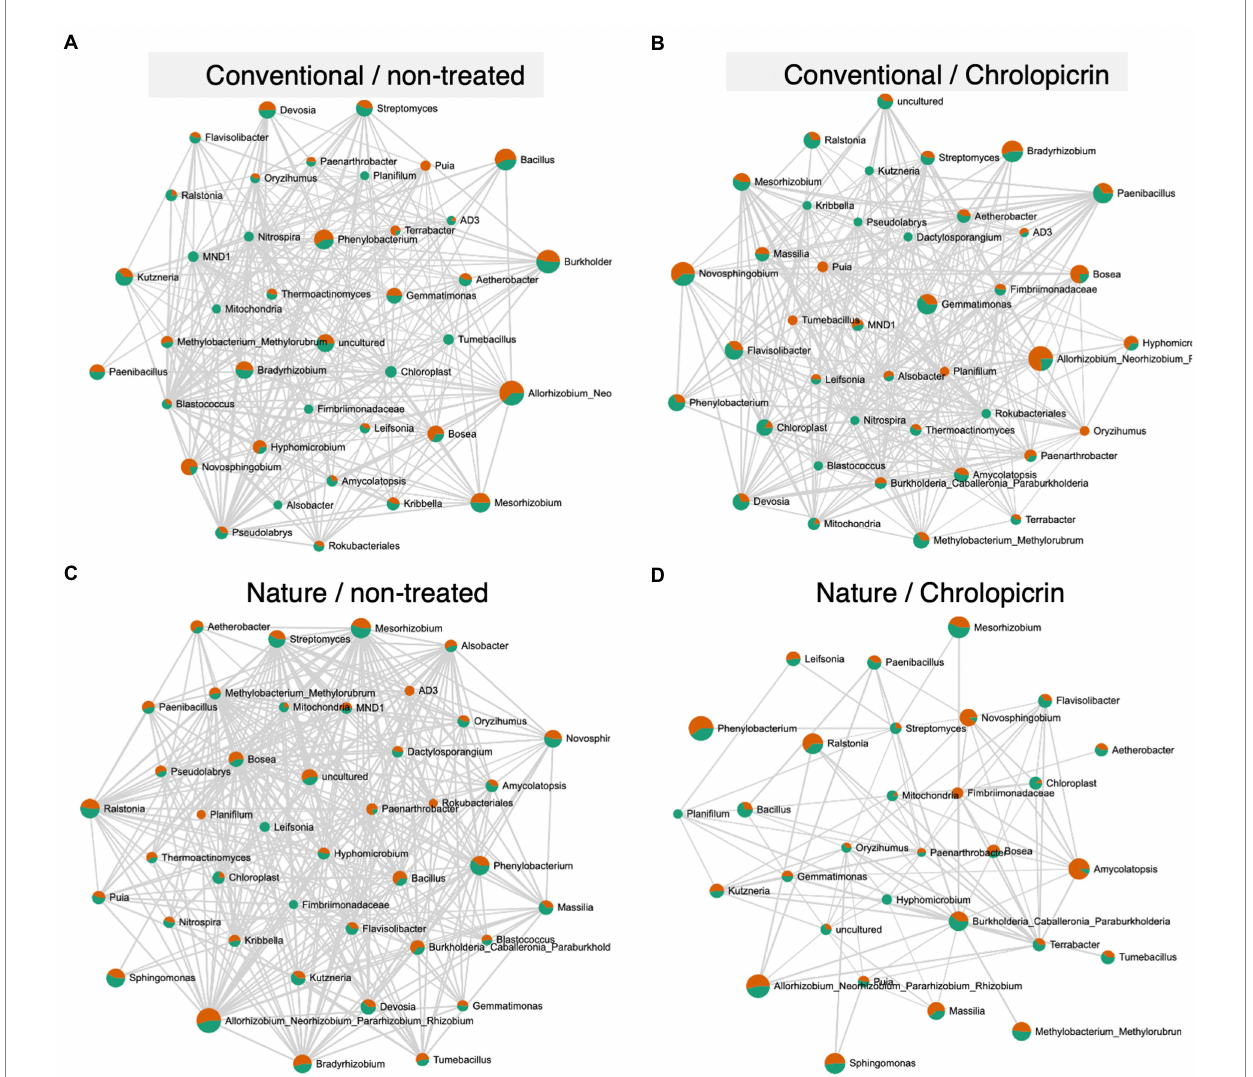
FIGURE 6 Network co-occurrence analysis of rhizosphere bacterial communities of soybean grown in non-treated conventional soil (A) , chloropicrin-treated conventional soil (B) , non-treated nature farming soil (C) , and chloropicrin-treated nature farming soil (D) . Correlation network generated using SparCC algorithm, with nodes representing taxa at the genus level and edges representing correlations between bacterial taxa. Co-occurrence networks are based on Pearson correlation with a threshold of r >